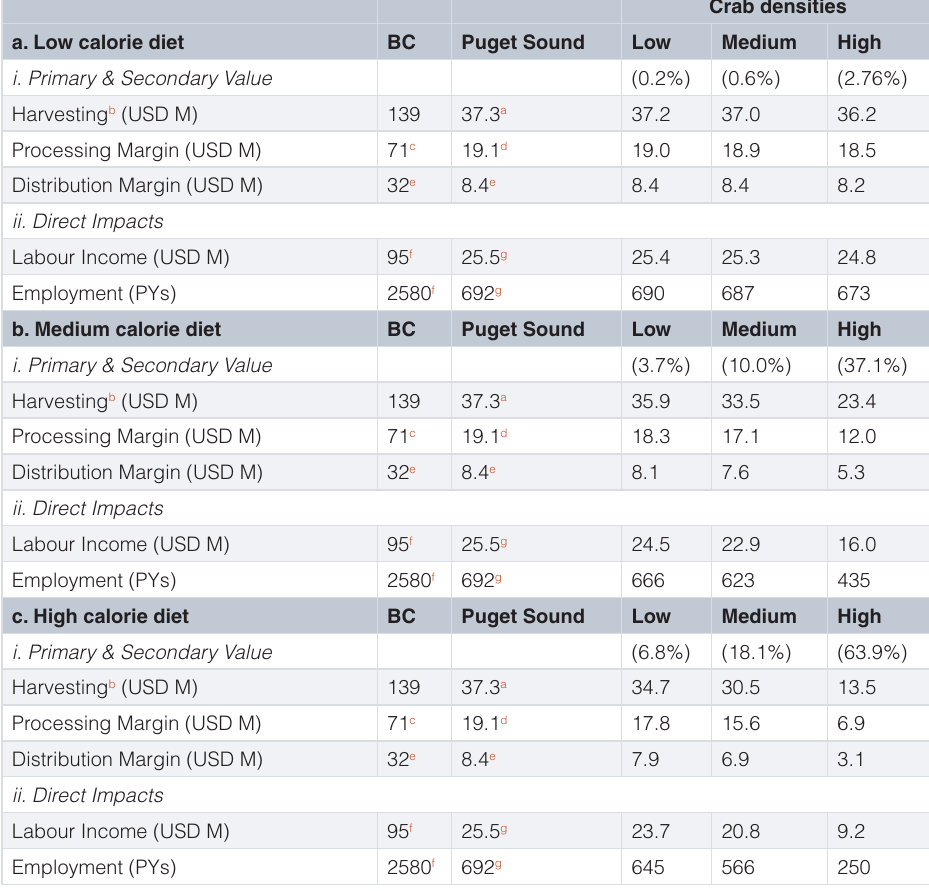
Table 2. Projected economic values for shellfish harvest and processing, under three scenarios each for green crab densities and caloric intakes. The % shellfish harvest value revenue losses (in parentheses) were used to calculate the loss of shellfish value in processing estimated from green crab invasion, while distribution value was calculated as 15% of harvesting and processing margin. Values calculated for Puget Sound were made using benefit transfer from British Columbia in 2005 72